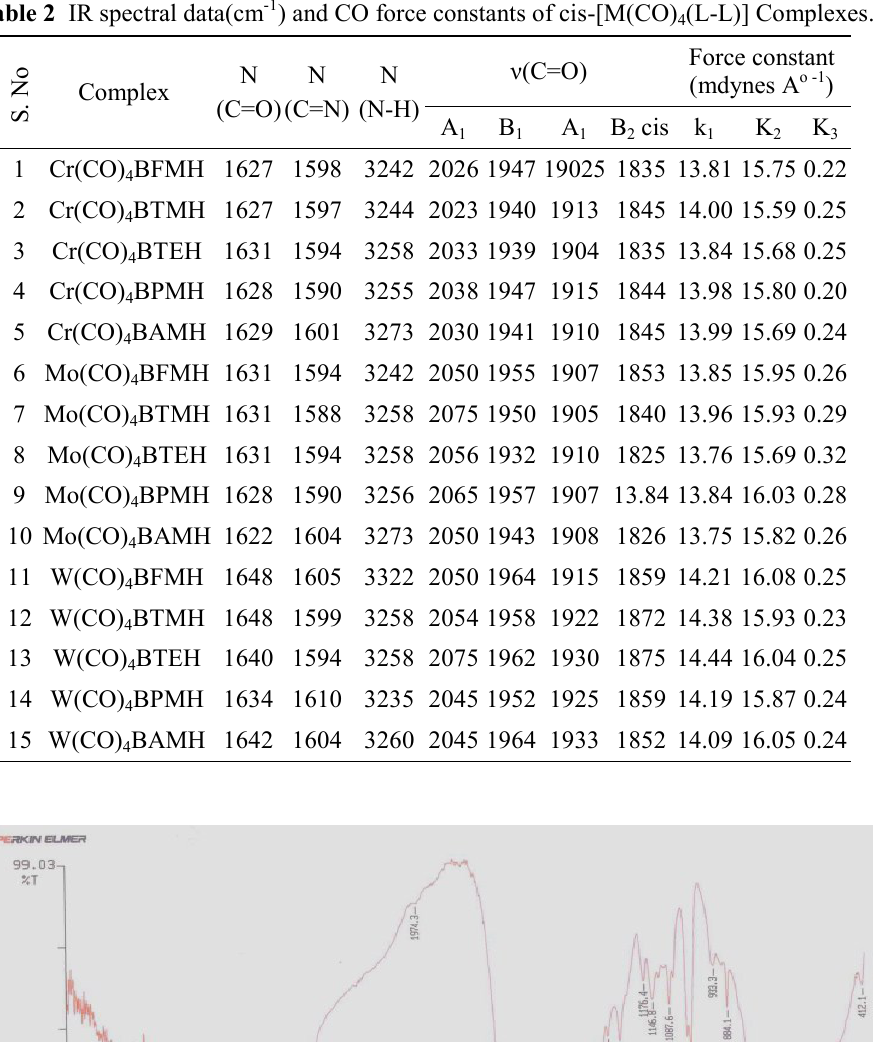
Table 2 IR spectral data(cm -1 ) and CO force constants of cis-[M(CO)